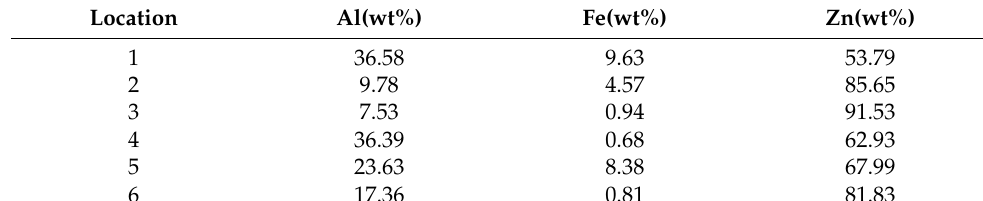
Figure 4. Organizational morphology and energy spectrum analysis of 475-30-W hot dip plating layer under SEM, ( a ) cross-sectional morphology of hot dip plating layer; ( b ) morphology of hot dip plating layer and corresponding micro-area energy spectrum analysis. Table 7. Point scan and surface scan results of 475-30-W hot dip plating.